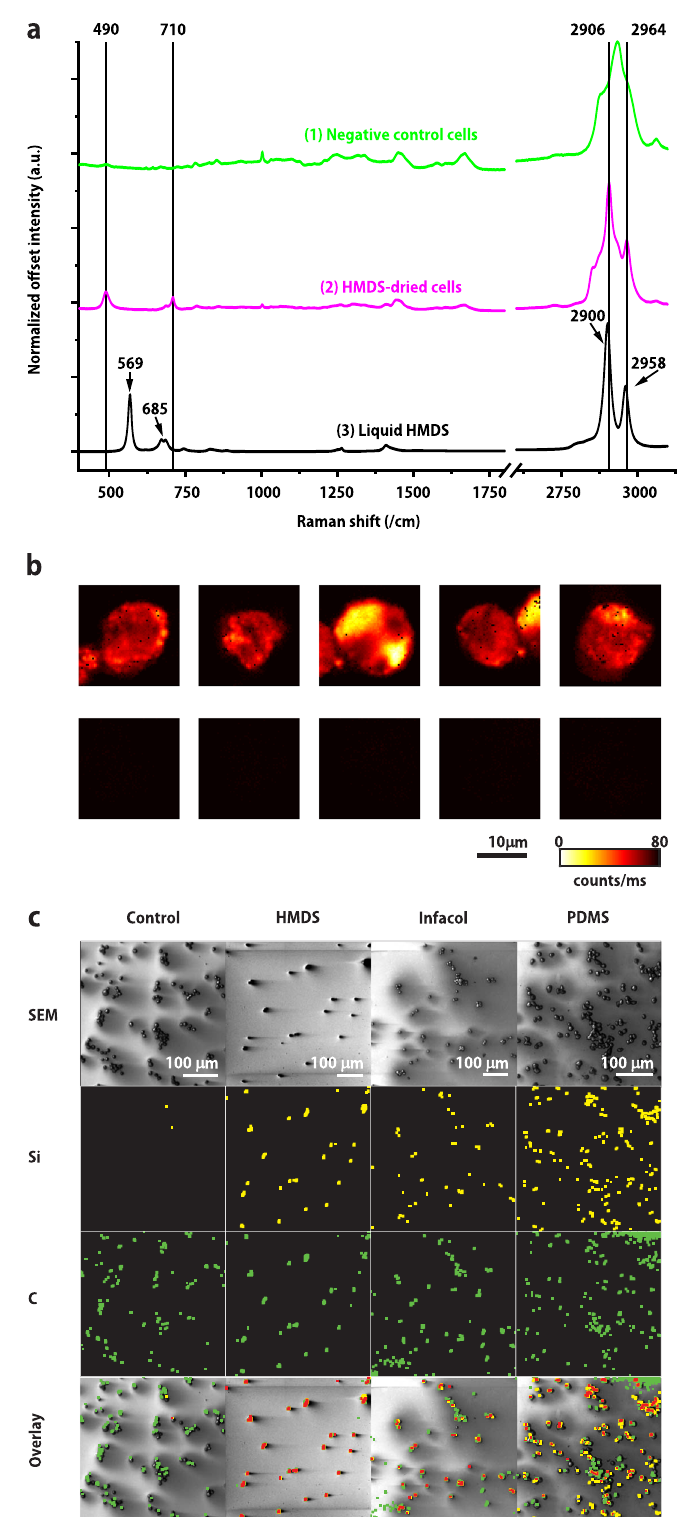
Fig. 1 Imaging spectroscopic analysis of individual cells. a Normalized mean Raman spectra of: (1) 5 negative control cells (green), (2) 5 HMDS-dried cells (magenta), (3) neat (liquid) HMDS (black). b Raman images of HMDS-dried cells (top row) and negative control cells (bottom row) obtained by integration of the band between 450 and 550 cm − 1 , the region in which the peak assigned to Si – C bonds is located. Raman images were acquired with 35 mW laser excitation power, 100 ms illumination time and 0.31- µ m scanning step size. c AES/SEM inspection of the silicon (yellow) and carbon (green) content of cells incubated with silicones compared to non-incubated samples (negative controls). In the same locations, overlapping with cells as shown by SEM, both silicon and carbon are found (overlapping dilated pixels corresponding to both Si and C are indicated in red). The original AES spectra revealing also the presence of N 1s in all cells are provided in